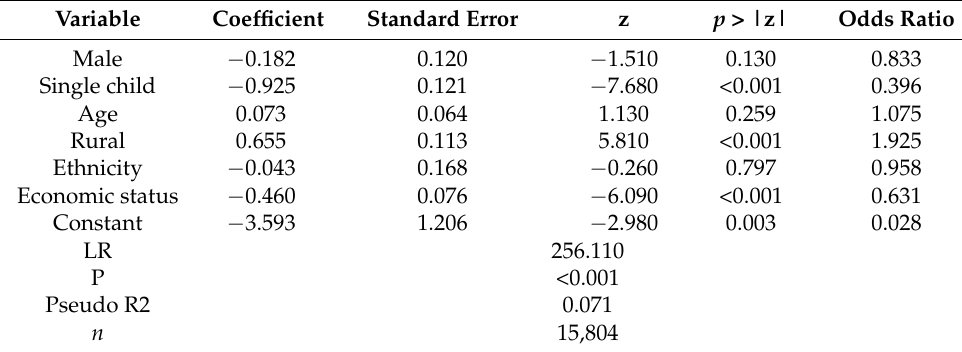
Table 2. Logistic regression model for the left-behind